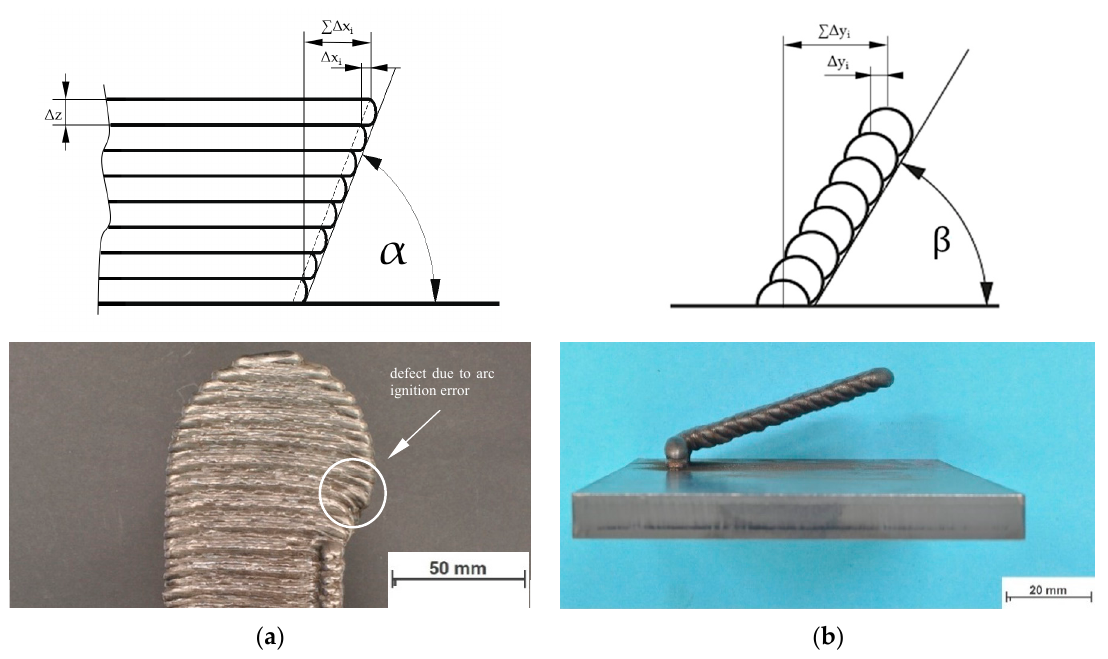
Figure 7. ( a ) Inclined wall in longitudinal direction: schematic diagram and use case for the AM-part; ( b ) inclined wall in transversal direction: schematic diagram and preliminary test.